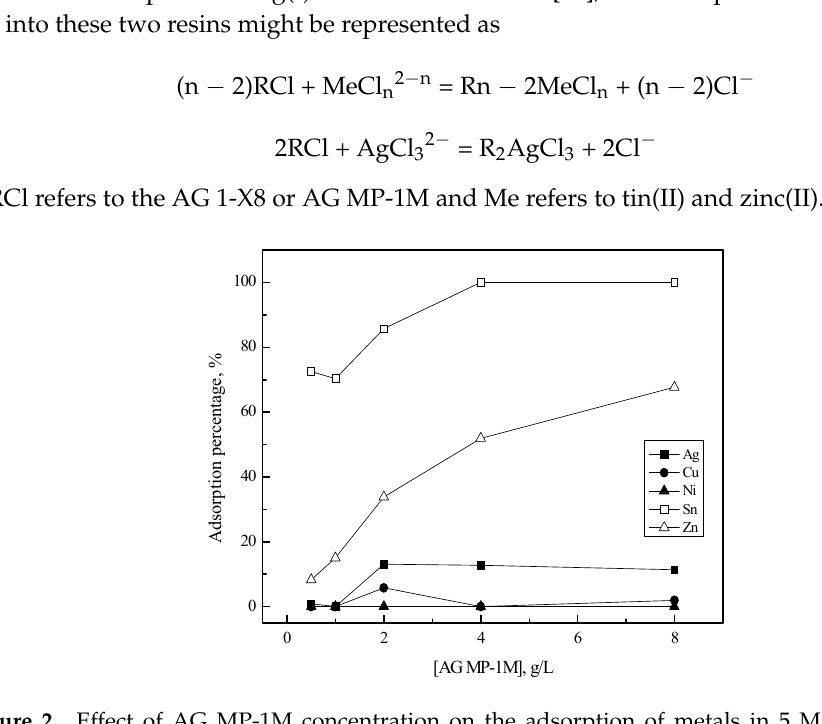
Figure 2. Effect of AG MP-1M concentration on the adsorption of metals in 5 M HCl solution. [AG MP-1M] = 0.5–8 (g/L), time = 6 h, shaking speed = 200 rpm.